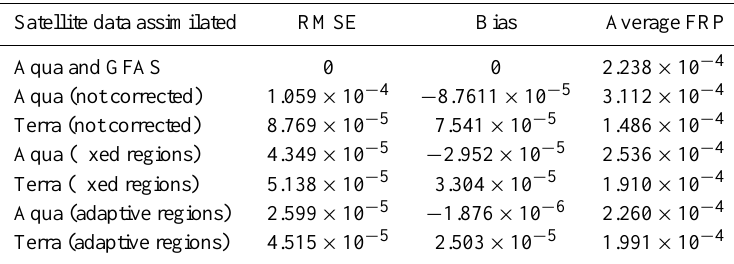
Table 1. RMSE and bias of mean global FRP in mWm − 2 for the year 2012 for Aqua- and Terra-GFAS with linear regression applied, as compared to Full-GFAS, fixed and adaptive